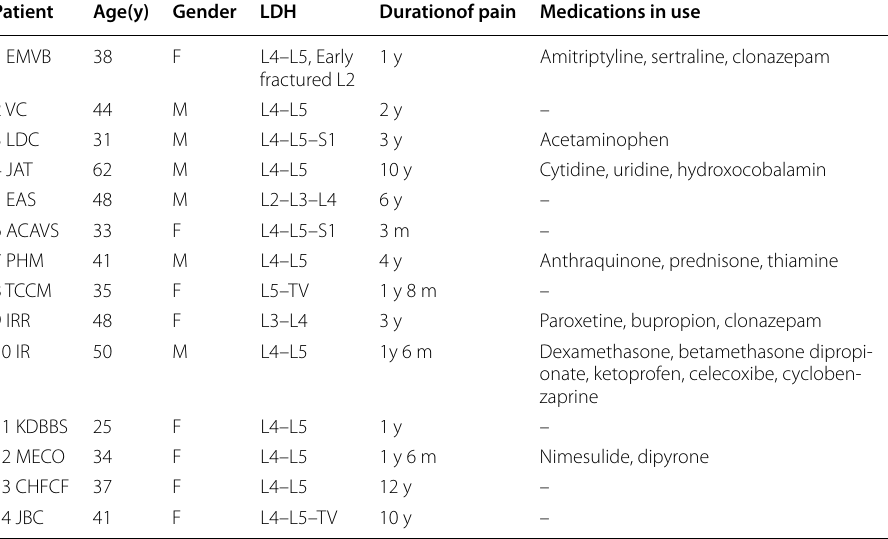
Table 1 Patients’